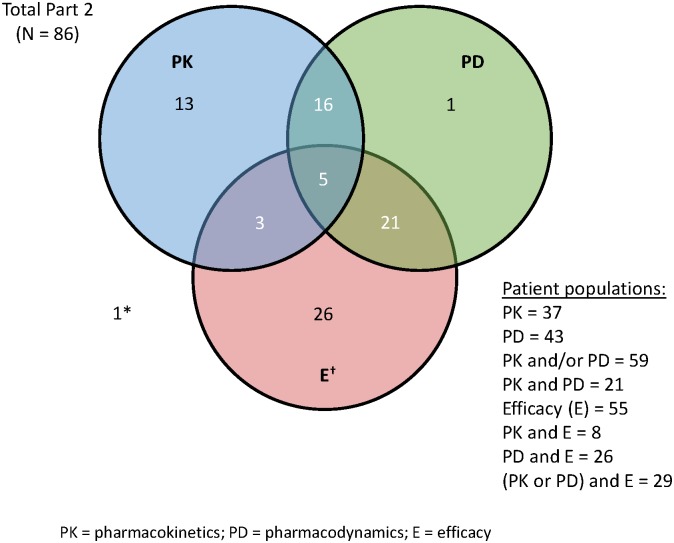
Patient populations.